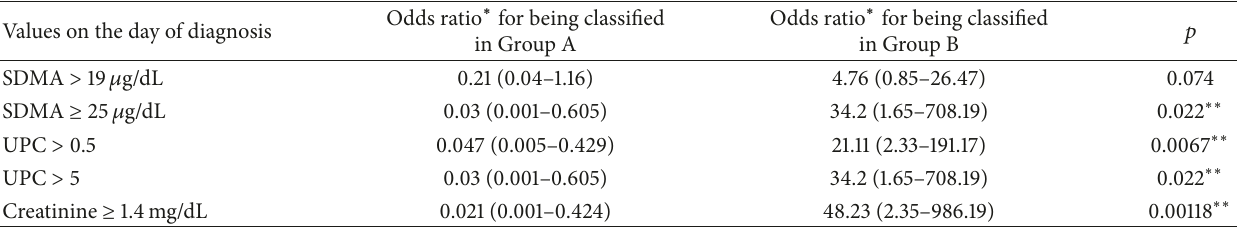
Table 2: Odds ratio for being classified in Group A or Group B after six months of follow-up depending on several cut-off values of kidney parameters on the day of diagnosis in 39 dogs with leishmaniosis.